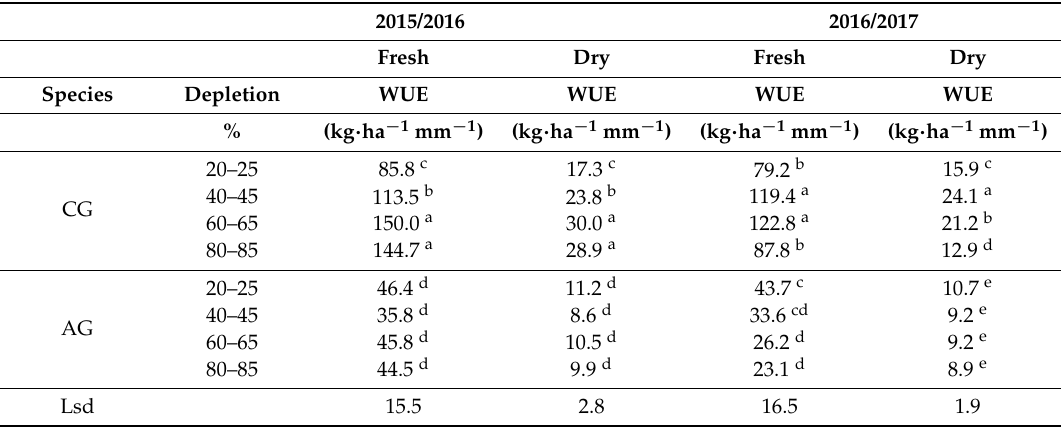
Table 7. Water use efficiency of commercial and African ginger in the 2015/2016 and 2016/2017 cropping